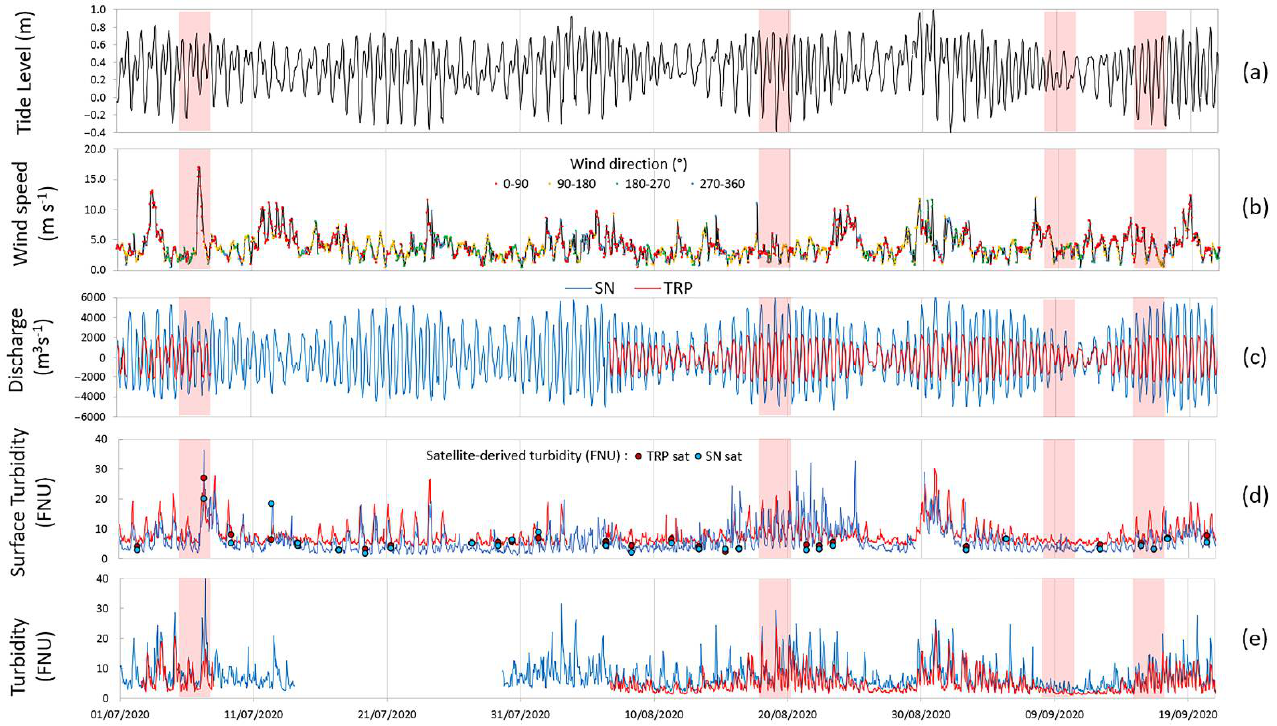
Figure 7. July–September 2020: hourly time series of tidal level ( a ) and wind speed and direction (red = 0°–90°, yellow = 90°–180°, green = 180°–270°, cyan = 270°–360°) ( b ), measured at the Lido Sud station; time series of discharge estimated with the index-velocity method from data of the bottom- mounted ADCPs (positive values of discharge indicate a seaward flow) ( c ); time series of surficial turbidity measured at fixed TRP and SN stations (circles represent turbidity values extracted from satellite maps at the two stations) ( d ); the vertically averaged turbidity derived from the conversion of acoustic backscatter from the bottom-mounted ADCPs ( e ). Red areas mark the periods described and discussed in text.